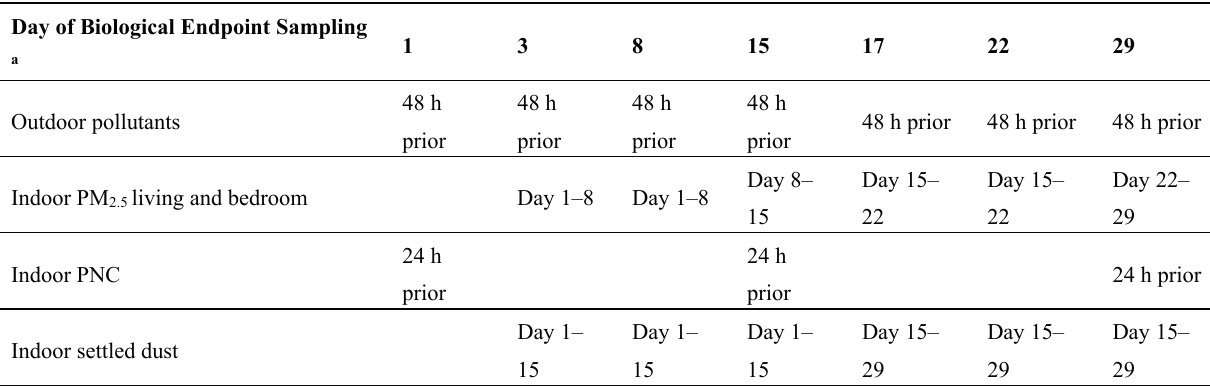
Table 1. Sampling periods used for exposure assessment in relation to 7 repeated health-related